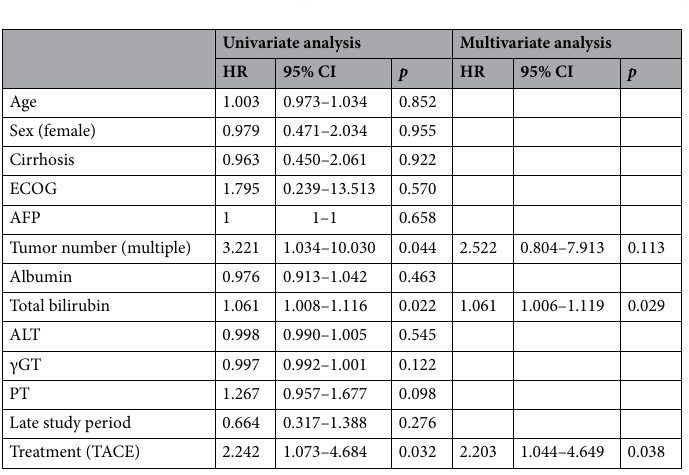
Table 4. Univariate and multivariate analysis of prognostic factors associated with long-term survival in propensity score-matched patients (n = 40). HR hazard ratio, CI confidence interval, ECOG Eastern Cooperative Oncology Group, AFP alfa-feto protein, ALT alanine transaminase, γGT γ glutamil transferase, PT prothrombin time, TACE transarterial chemoembolization.